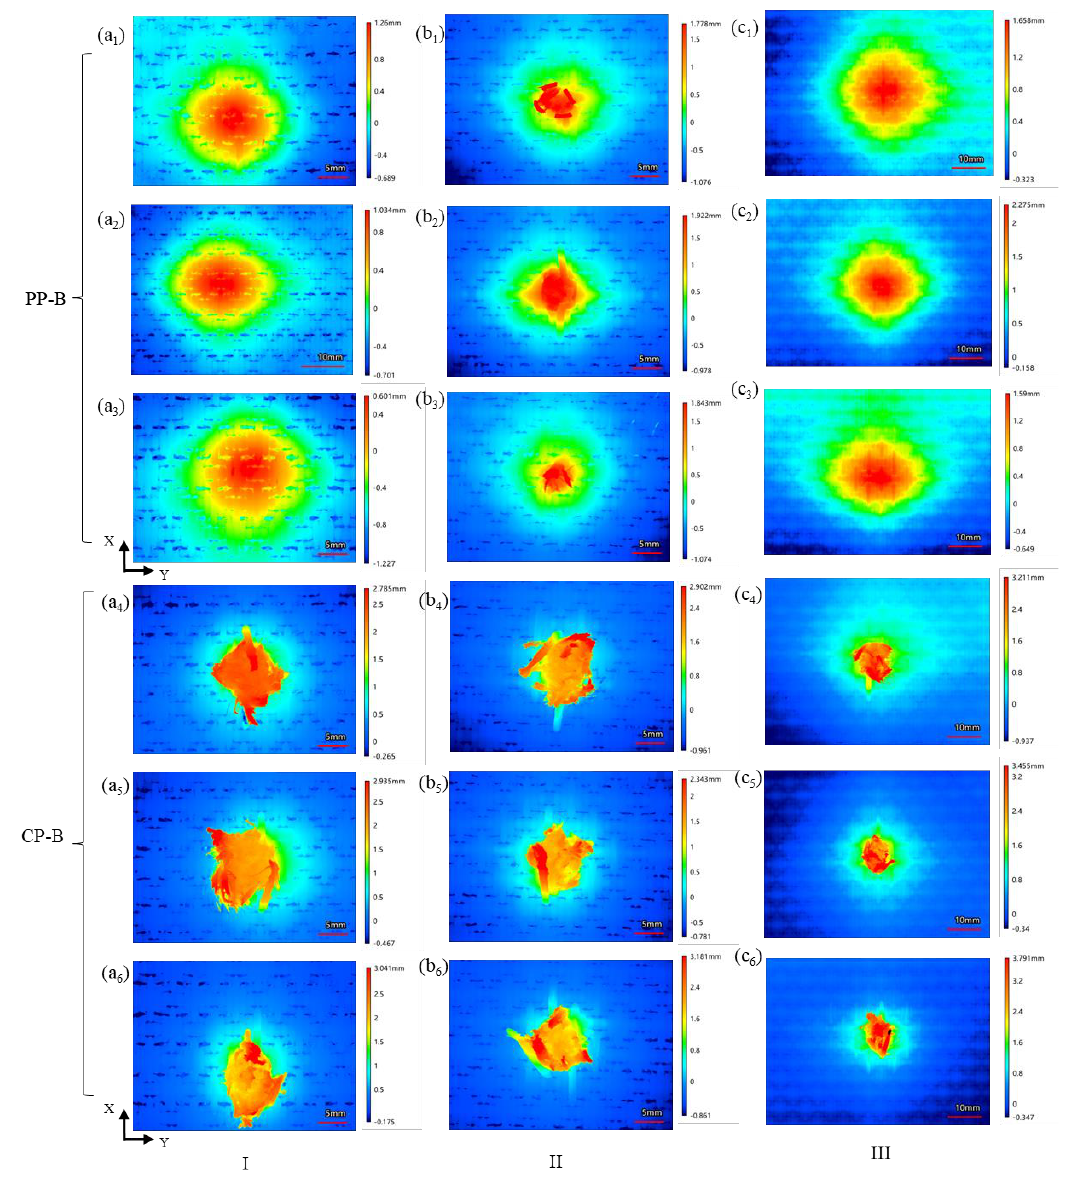
Figure 11. 3D profiler scan results for back-face damage morphology of the composite panel sam-